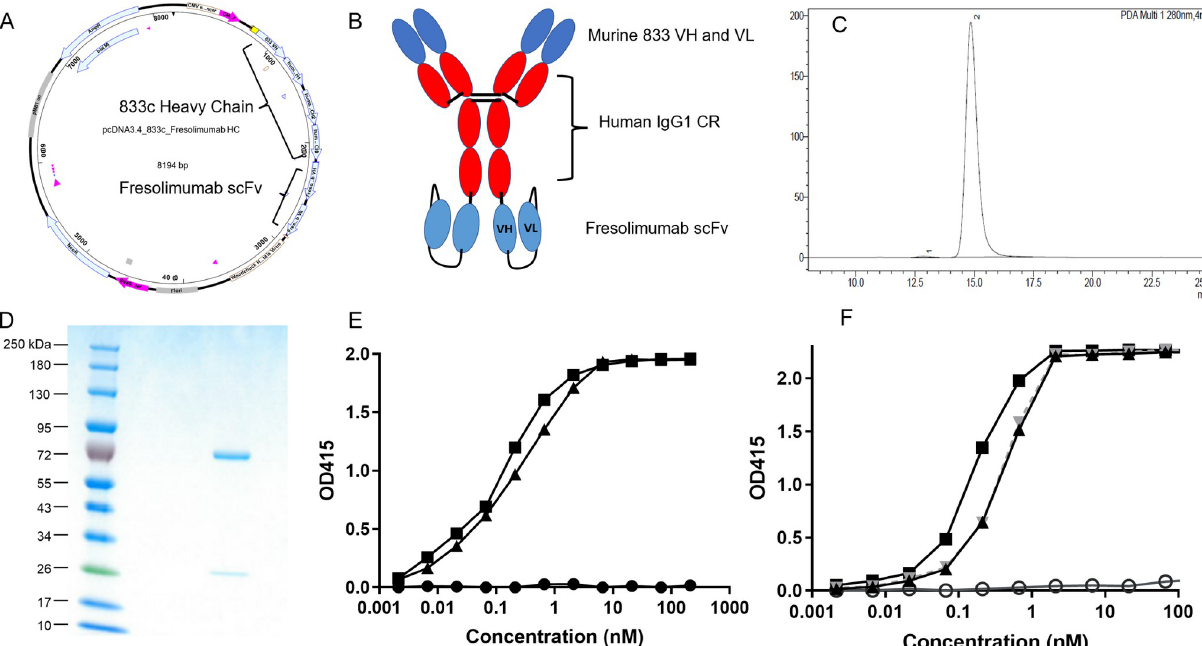
Fig 1. Genetic engineering and characterization of 833c&Freso. ( A ) Plasmid map for 833c&Freso heavy chain expression. Fresolimumab single-chain variable fragment (scFv) was cloned into the 3’ end of the 833c CH3 domain. ( B ) 833c&Freso schematic: scFv is attached to the CH3 domain at the 3’ end. Red: human domains, blue: murine domains. CR: constant region, VH and VL: variable regions. ( C ) Size exclusion chromatography and ( D ) Reducing SDS-PAGE of purified 833c&Freso. ( E ) ELISA binding to rat aminopeptidase P2 of 833c&Freso (triangles), 833cX&Freso (circles) and 833c (squares) (see Methods). ( F ) ELISA binding to TGF- β 1 of 833c&Freso (triangle, black), 833cX&Freso (triangle, gray), fresolimumab (squares) and huIgG4, a isotype-matched control IgG for fresolimumab (open circles) (see Methods).